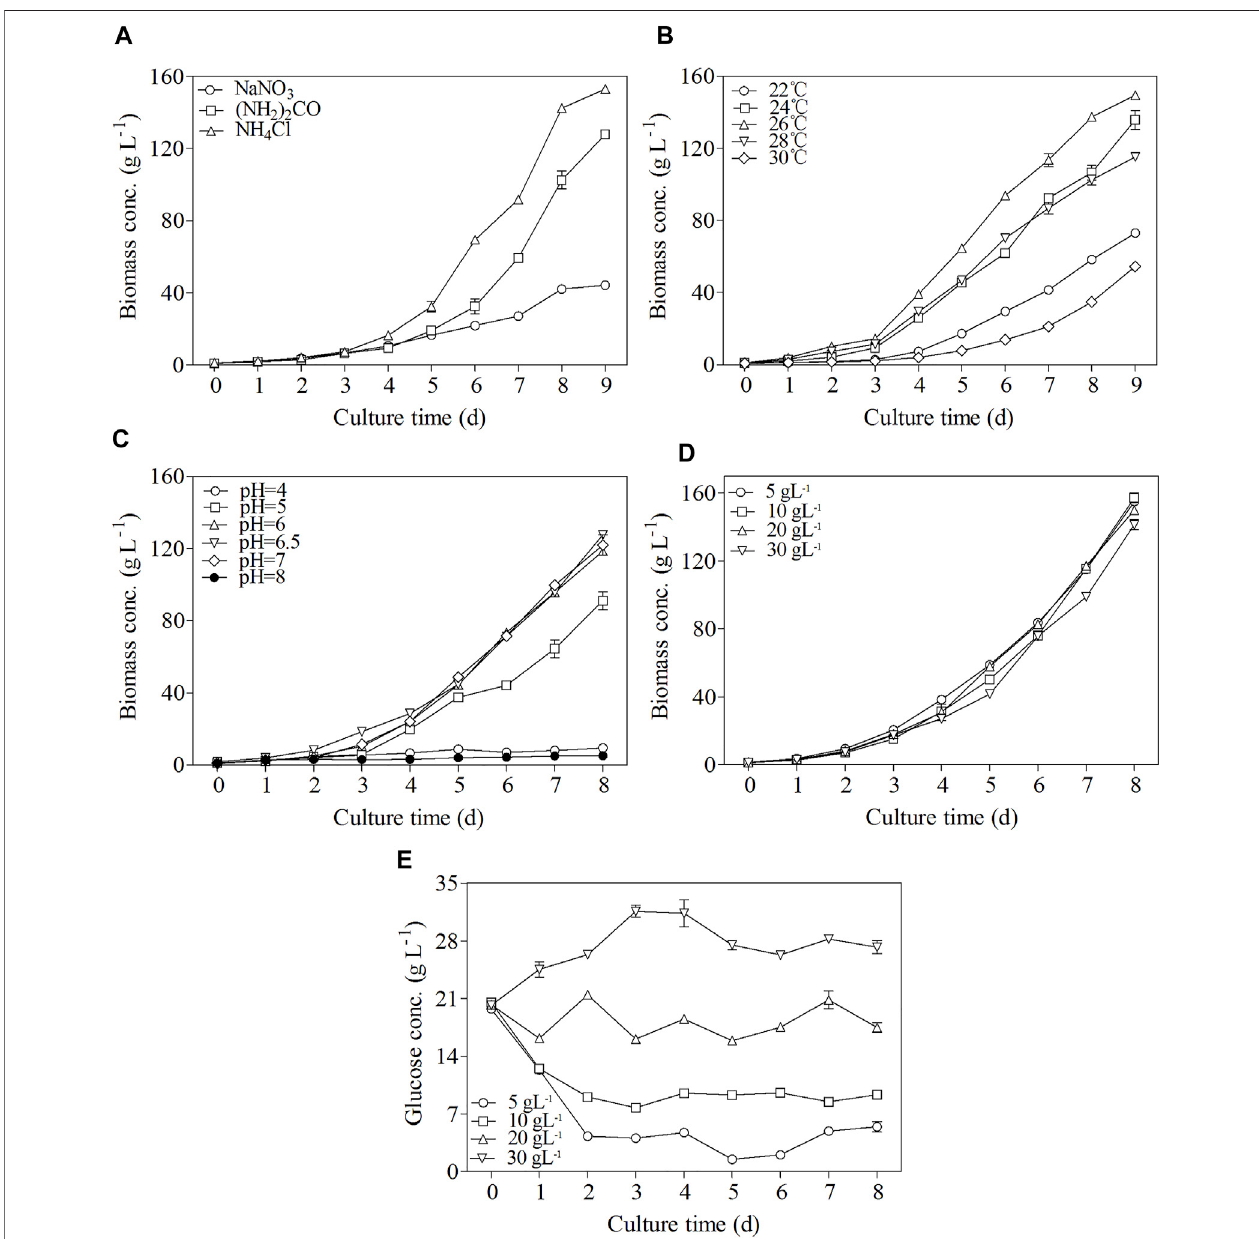
FIGURE 2 | Effects of different nitrogen sources (A) , temperature (B) , pH (C) , glucose concentration (D) , and change of glucose concentration (E) on C. zo fi ngiensis cellular growth under heterotrophic conditions in 7.5 L fermentors. Data are mean values ±SD from triplicate measurements (n = 3). All cultures were performed in 7.5 L fermentors using NH 4 Cl as the nitrogen